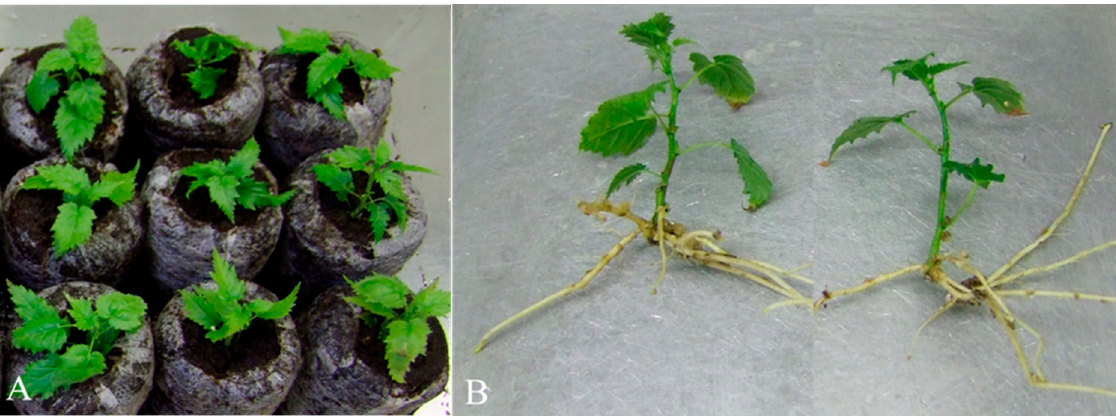
Figure 5. Rooting of Corylus avellana , cultivated variety Tonda Gentile Romana, after cryopreservation: ( A ) microcuttings from cryopreserved explants after rooting induction (17.6 µM IBA for 7 days) and transferring in Jiffy-7 ® , ( B ) rooted microcuttings originated from cryopreserved ABs ( left ) and from the control.